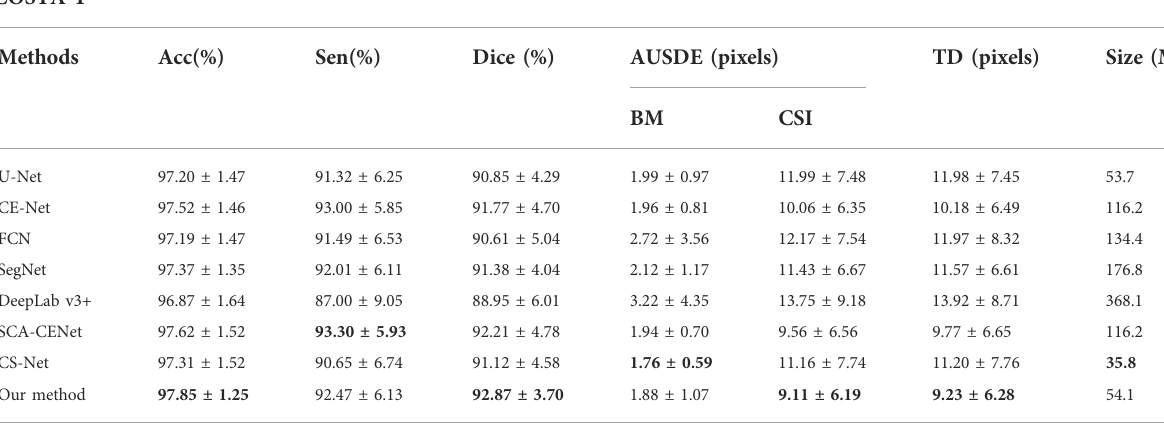
TABLE 2 Quantitative segmentation results of different deep learning methods on the COSTA-T dataset.